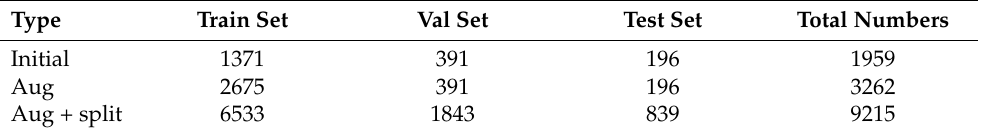
Table 1. The specific numbers of the original dataset and enhancement dataset.